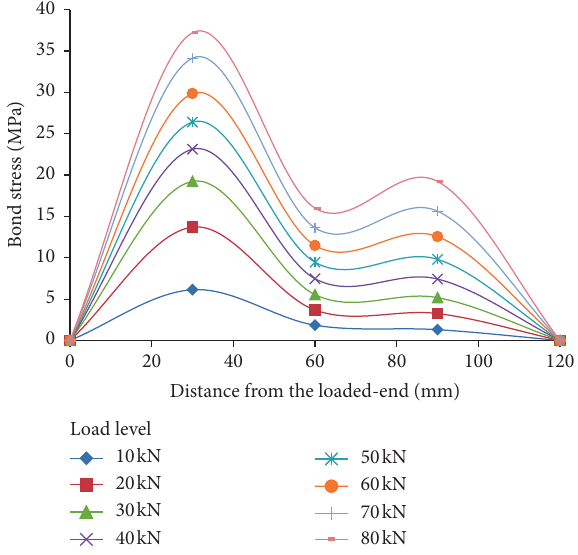
Figure 15: Average bond stress distribution for ribbed bar-rein- forced OPC.